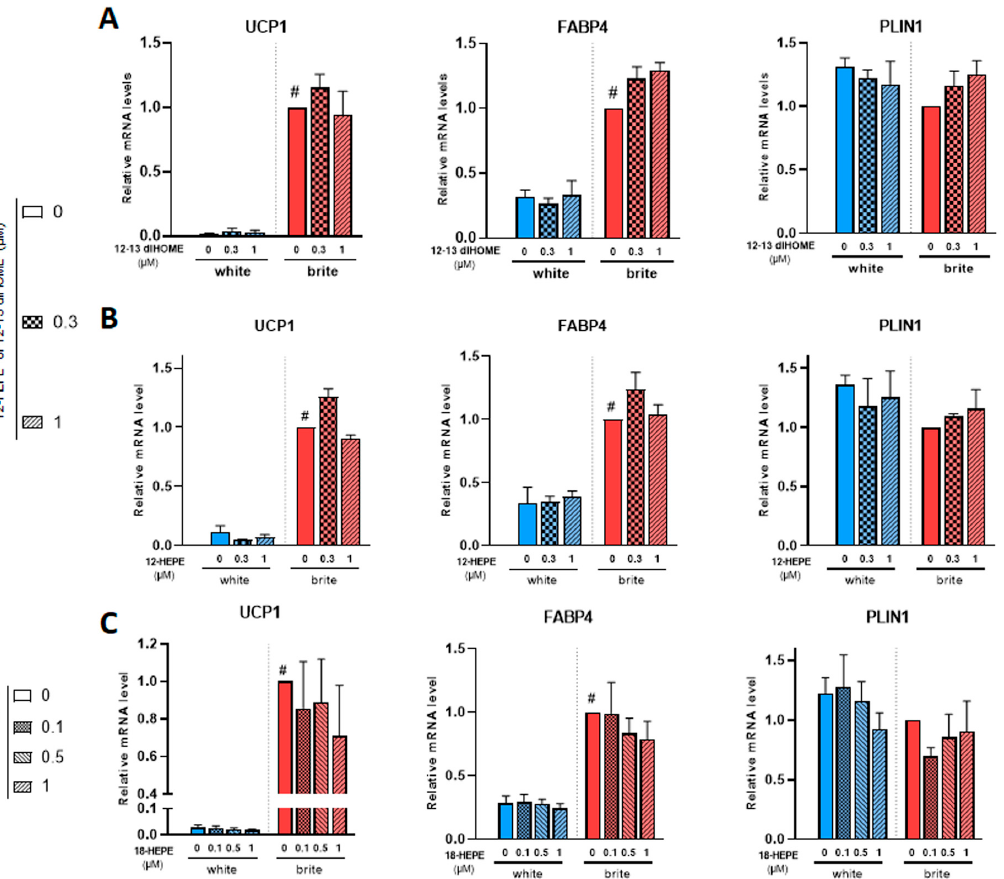
Figure 4. Effects of 12,13 diHOME, 12-HEPE and 18-HEPE on UCP1 mRNA expression. White hMADS adipocytes (blue columns) were induced to convert (from day 14 to day 18) into brite adipocytes (red columns) in the presence of various amounts of 12,13 diHOME ( A ), 12-HEPE ( B ) or 18-HEPE ( C ) in the absence (white) or the presence of 100 nM rosiglitazone (brite). UCP1, FABP4 and PLIN1 mRNA levels were measured. Histograms display mean ± SEM of three to nine inde- pendent experiments; statistics were conducted through a two-way ANOVA with Tukey’s multiple comparisons test, where p < 0.05 was considered significant: #: p < 0.05, white (blue) vs. brite (red) adipocyte.